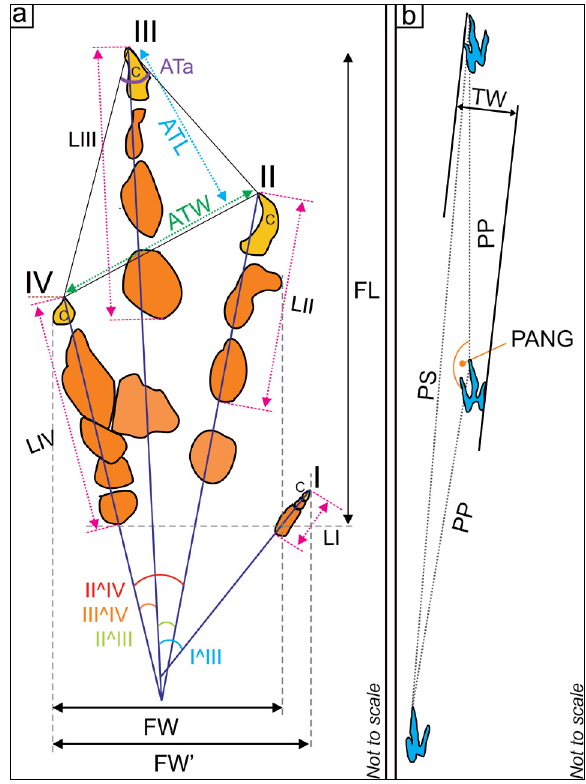
Figure 2: Key morphological features of the tracks and their measure- ments obtained for the ichnological analyses: (a) track measurements and (b) trackway